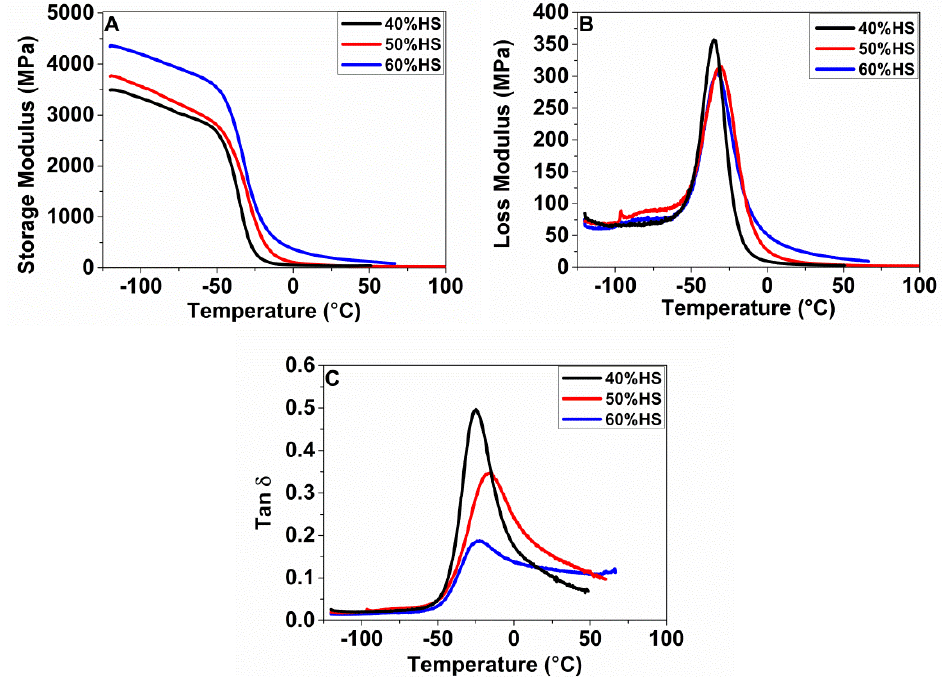
Figure 2. WAXD pattern of solid TPUs with different HS%.